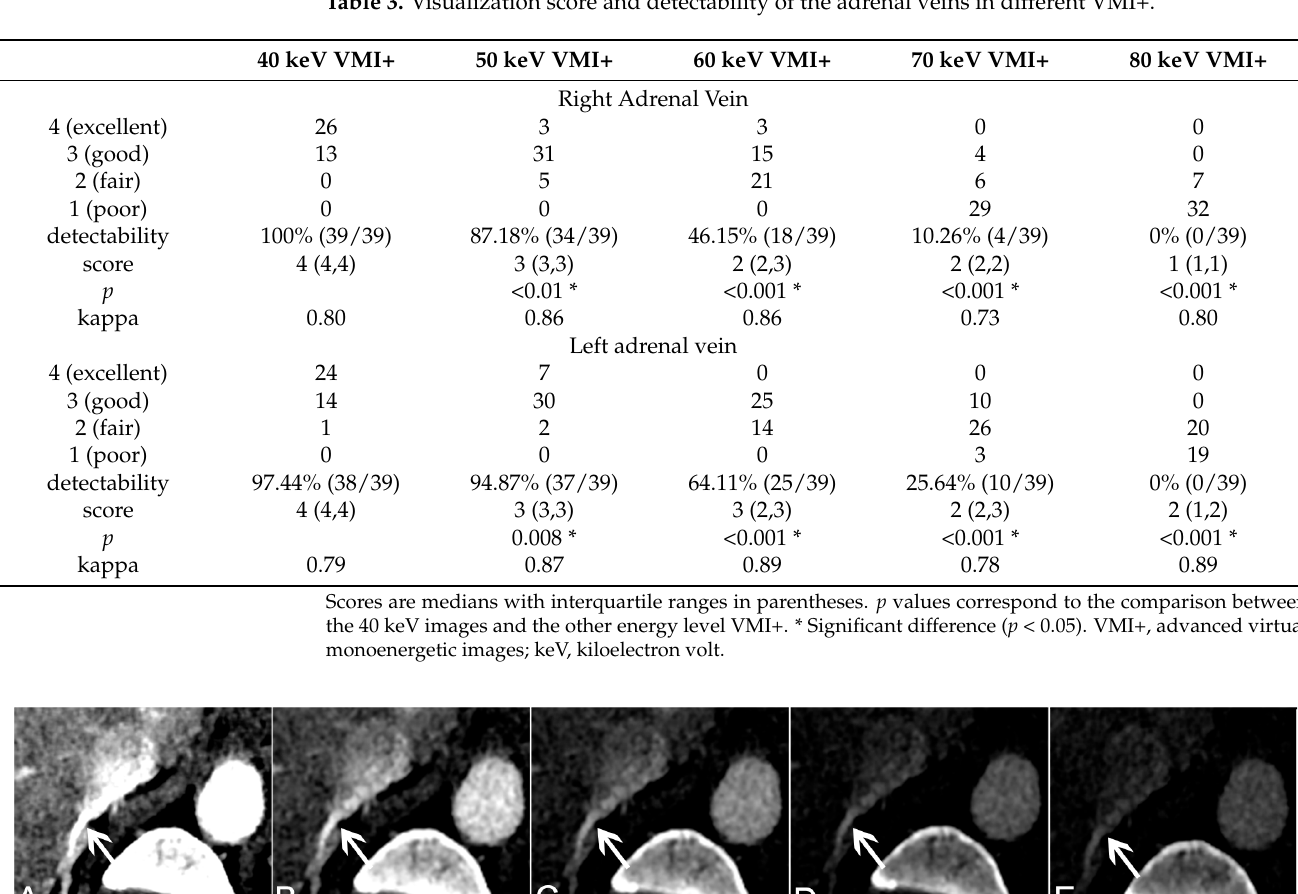
Table 3. Visualization score and detectability of the adrenal veins in different VMI+. 40 keV VMI+ 50 keV VMI+ 60 keV VMI+ 70 keV VMI+ 80 keV VMI+